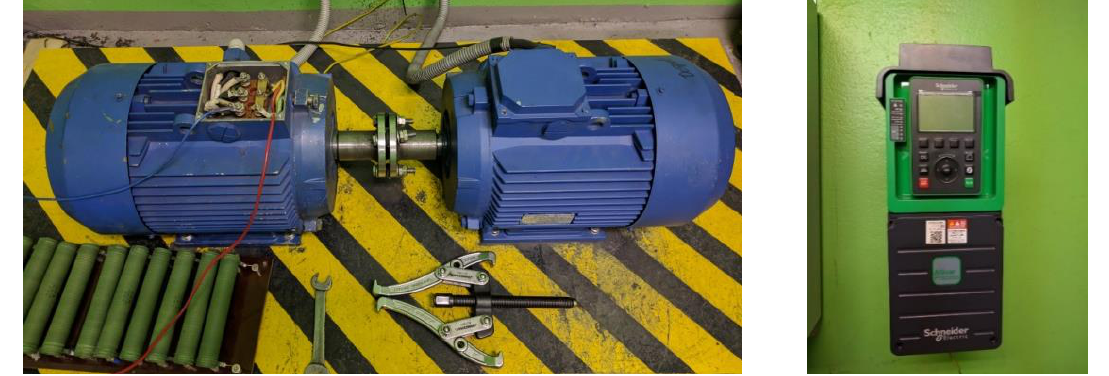
Figure 4. Equipment for experiments.